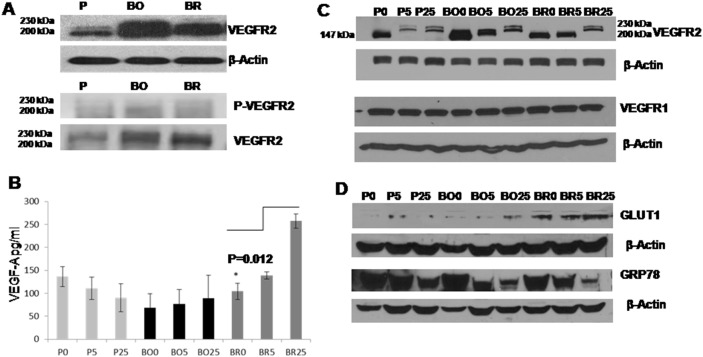
The expression of VEGF and its receptor VEGFR2 in MDA-MB-231 cells and its metastatic variants varies with glycemic conditions.(A) Western blots show the difference in VEGFR2 and phospho-VEGFR2 in MDA-MB-231 parental (P), bone metastatic (BO) and brain metastatic (BR) variants growing in DMEM containing 25 mM glucose. (B) Graph represents the mean of four independent ELISA experiments measuring the total VEGF-A secreted in the conditioned media, (error bars represent ± standard deviation). Statistical analysis showed no significant difference in the amount of VEGF-A secreted when the MDA-MB-231P and MDA-MB-231BO cells were grown under the different glucose concentrations. However, MDA-MB-231BR cells produced significantly higher levels of VEGF-A (p = 0.012) when grown in DMEM containing 25 mM of glucose compared to 0 mM of glucose. Figure abbreviations P: MDA-MB-231 Parental, BO: MDA-MB-231Bone and BR: MDA-MB-231Brain; cell lines were grown in DMEM 0, 5 and 25 mM glucose for 24 hrs without FBS. (C) VEGFR2 expression in MDA-MB-231P, MDA-MB-231BO and MDA-MB-231BR cells. The 147 kDa band was the dominant band expressed at 0 mM glucose. The regular double bands (200 kDa and 230 kDa) were detected in all the cells at 25 mM glucose. The cells expressed the bands differentially when placed in 5 mM glucose media. The MDA-MB-231P cells produced the 200 and 230 kDa forms; the MDA-MB-231BO cells produced the 147 and 200 kDa forms while the MDA-MB-231BR cells did not express any of the mature glycosylated bands at 5 mM glucose concentration. The bottom blot shows the expression of VEGFR1 was constant and did not change among the cell lines nor under the different glucose conditions. (D) Blot shows MDA-MB-231BR cells produced higher levels of GLUT-1 protein than the other cell lines. GRP78 had the same expression pattern among the different cells and its expression had an inverse relationship with glucose concentration. Note: β-Actin was used in all the blots as protein loading control.